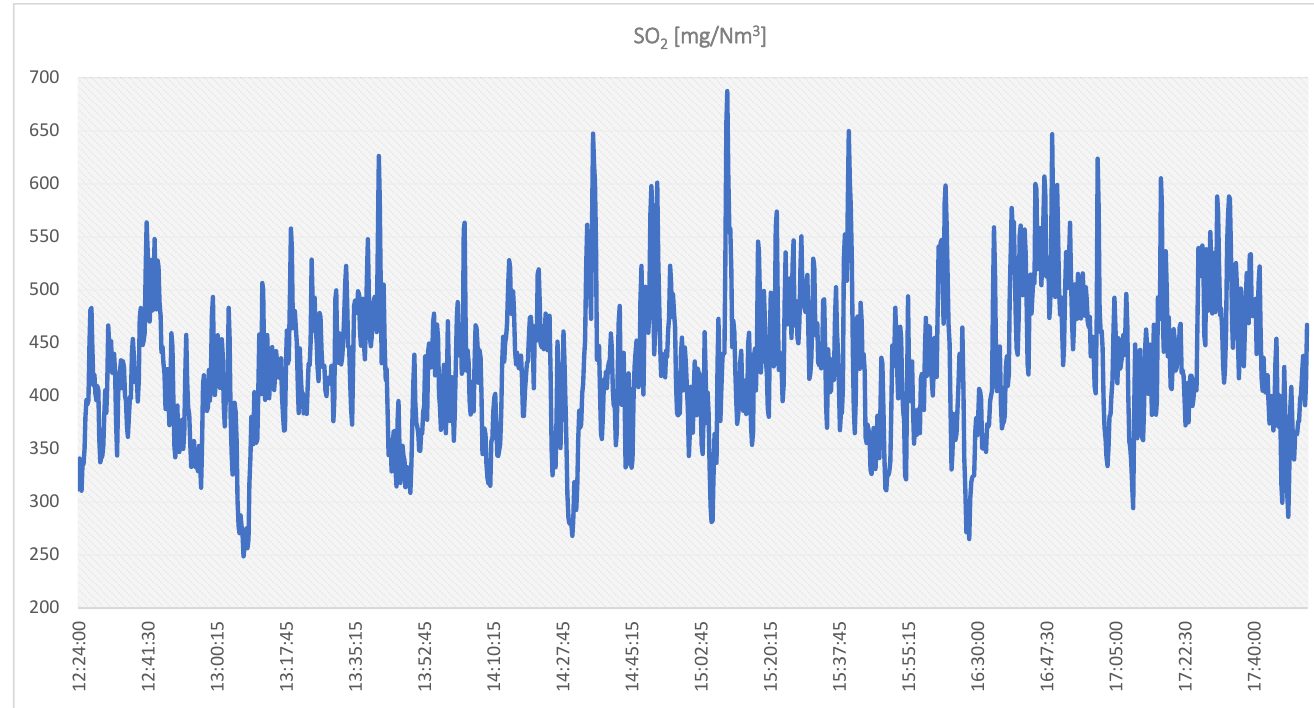
Figure 4. NOx emission trend during combustion test.